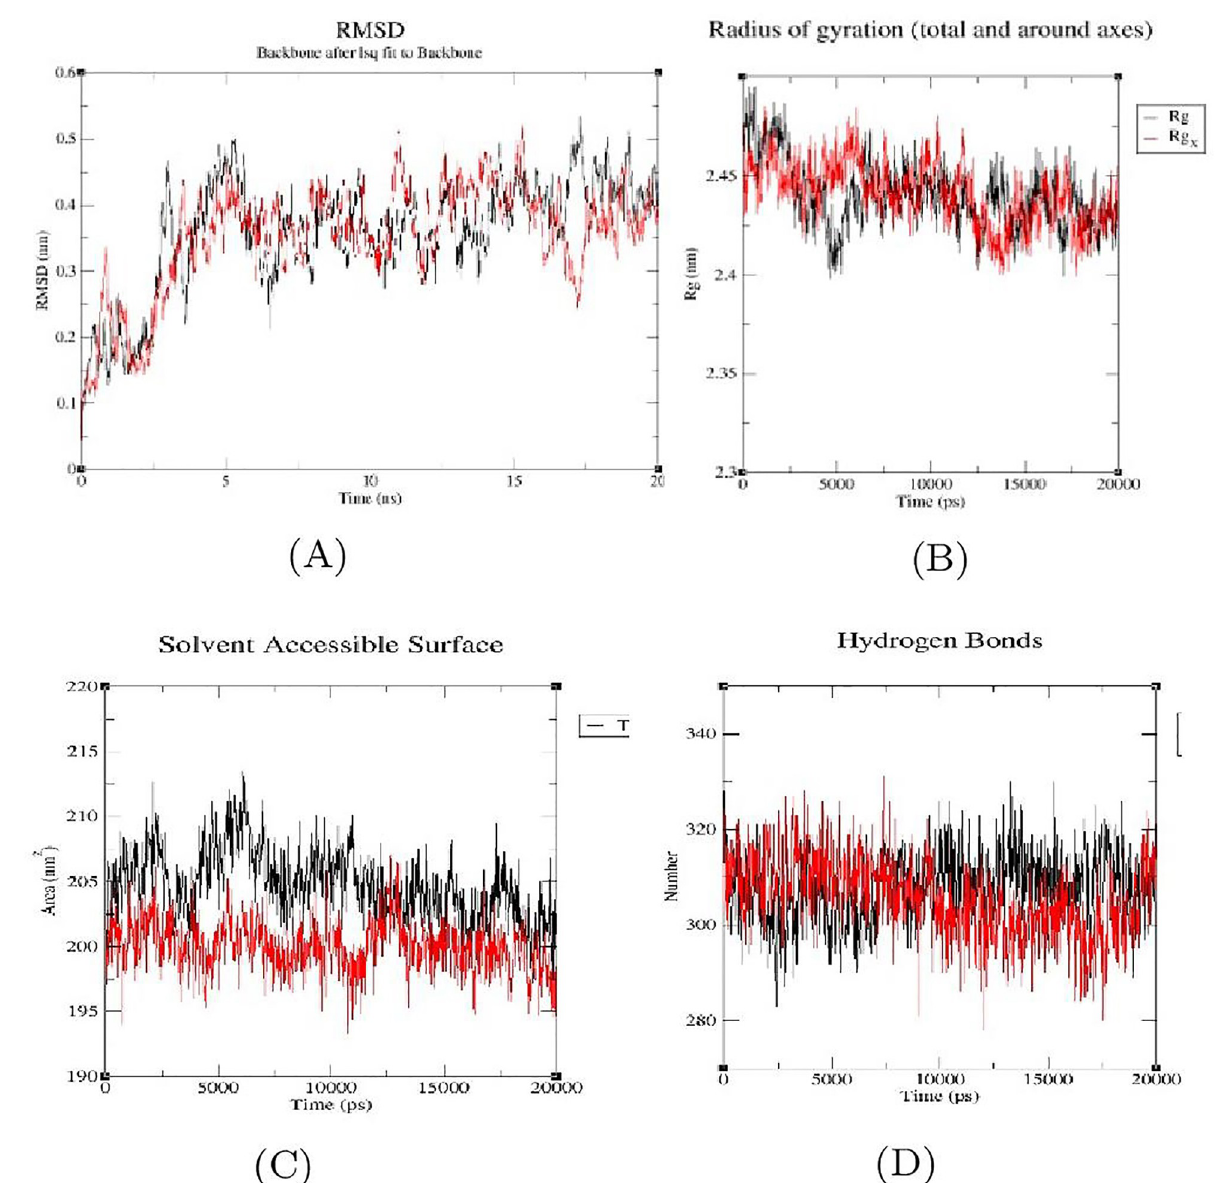
Fig 8. Analysis of RMSD (A), Rg (B), SASA (C) and Hydrogen (D) graphs of TOP2A (PDB: 5GWK) in complex with Ashwagandhanolide (Back color indicating protein alone and Red indicating protein-ligand complex).